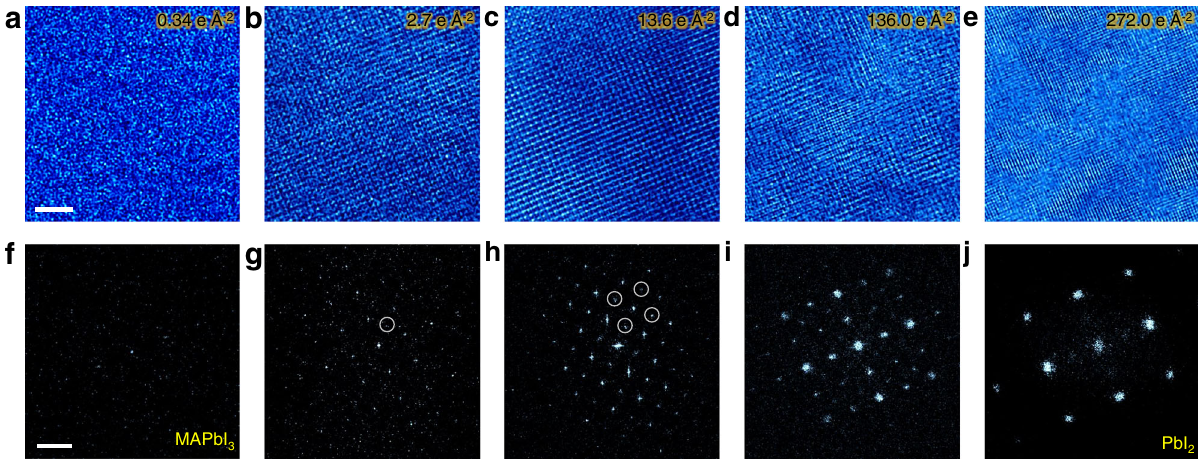
Fig. 1 Tracking structure evolution during the decomposition of MAPbI 3 . a – e Time-series HRTEM images during the degradation of MAPbI 3 under electron beam irradiation. The corresponding doses are marked on each panel. Scale bar, 4 nm. f – j The corresponding FFT patterns from MAPbI 3 to 6H- PbI 2 . Circles indicate the superstructure diffraction re fl ections. Scale bar 2 nm − 1